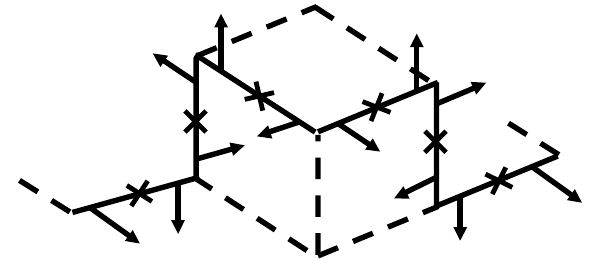
FIG. 4. The Frenet-Serret vector ˆ n for the same example as in Fig. 1. Arc inflection (deflection) points are